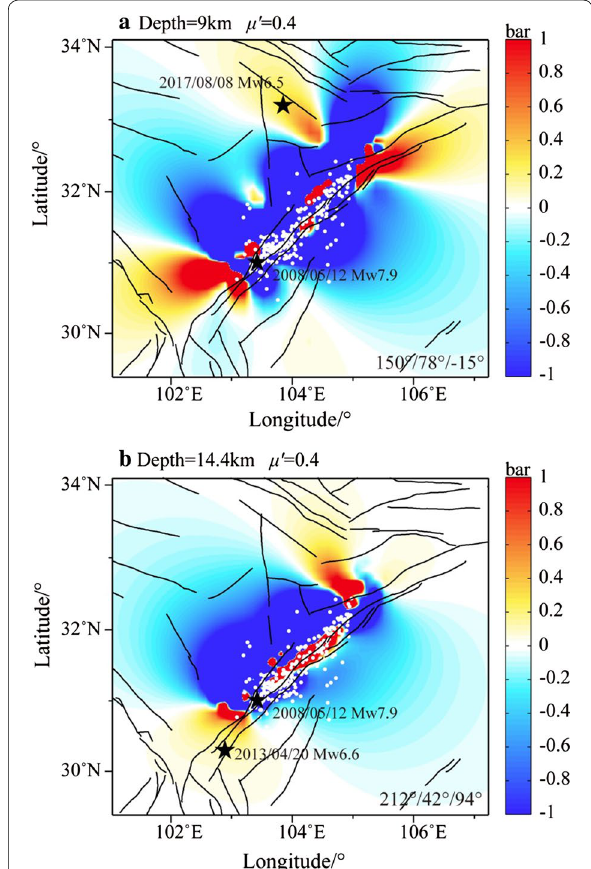
Fig. 7 Stress change imparted by the 2008 Wenchuan earthquake. a , b calculated at 9 km and 14.4 km depth with an effective friction coefficient of 0.4, respectively. The black stars are the epicenters of the Jiuzhaigou and Lushan earthquakes, and the yellow star is the epicenter of the Wenchuan earthquake, while the black circles denote the Wenchuan earthquake M L > 4 aftershocks in 1 day after main-shock. The black lines indicate the major active faults in this